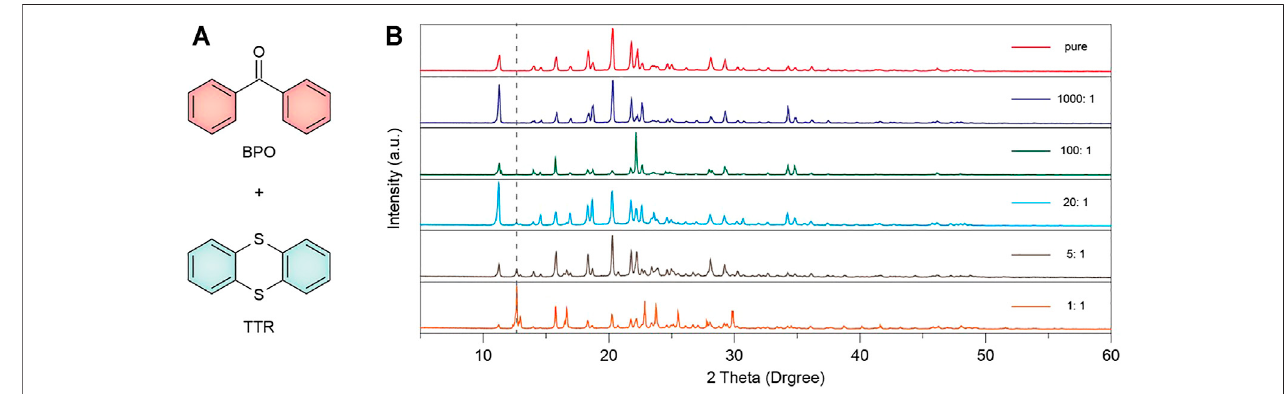
FIGURE 1 | (A) Chemical structures of the host matrices BPO and guest emitter TTR. (B) Powder XRD patterns of pure BPO and BPO/TTR doped crystalline materials at different molar ratios (1000:1, 100:1, 20:1, 5:1 and 1:1 Mol